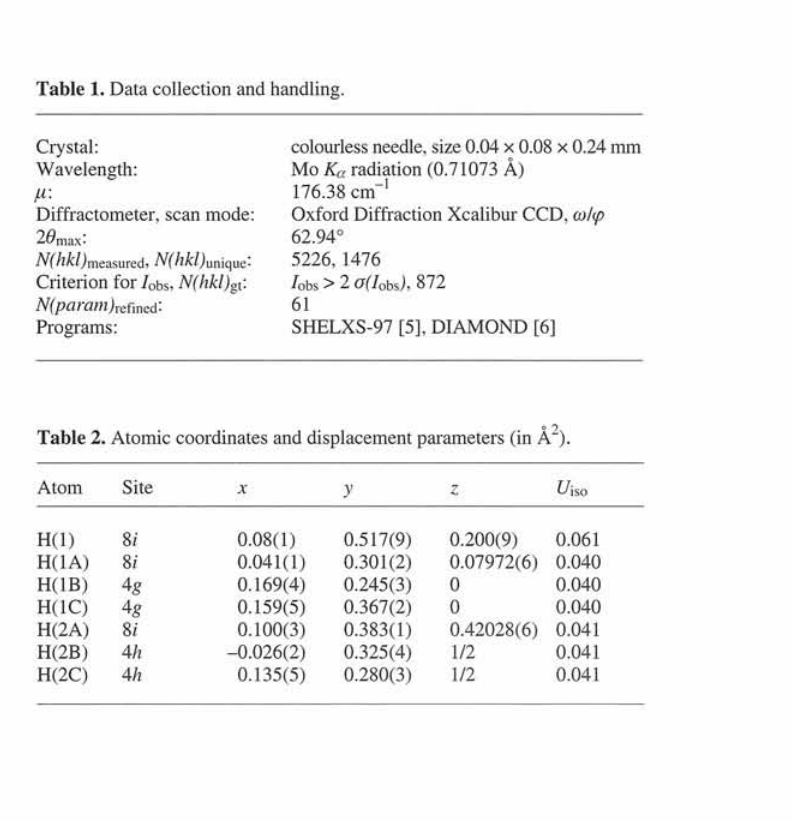
Table 1. Data collection and handling.